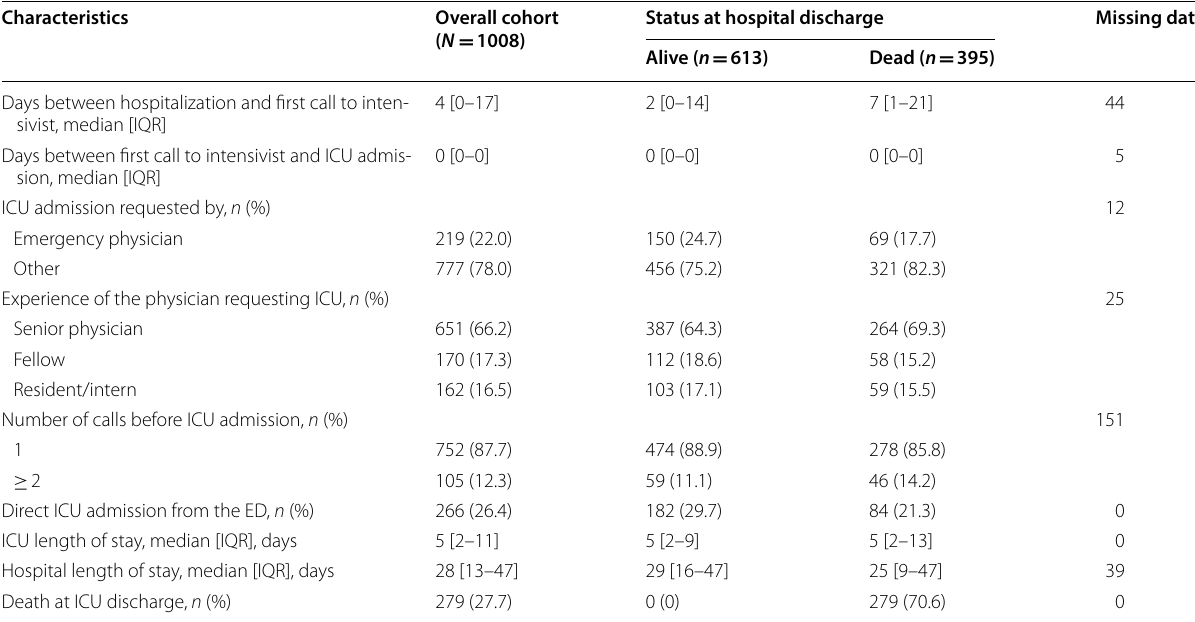
Table 2 Modalities of ICU admission and hospital mortality